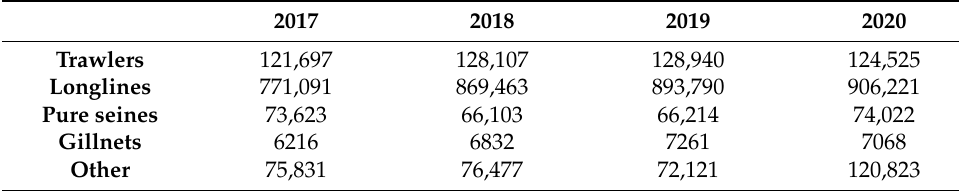
Table 2. Cell grid counts of global fishing gear classes from 2017 to